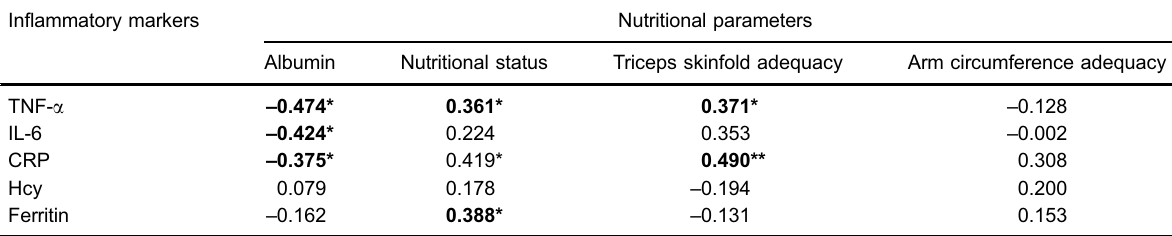
Table 6. Spearman ’ s correlation coef fi cients between in fl ammatory markers and nutritional parameters. In fl ammatory markers